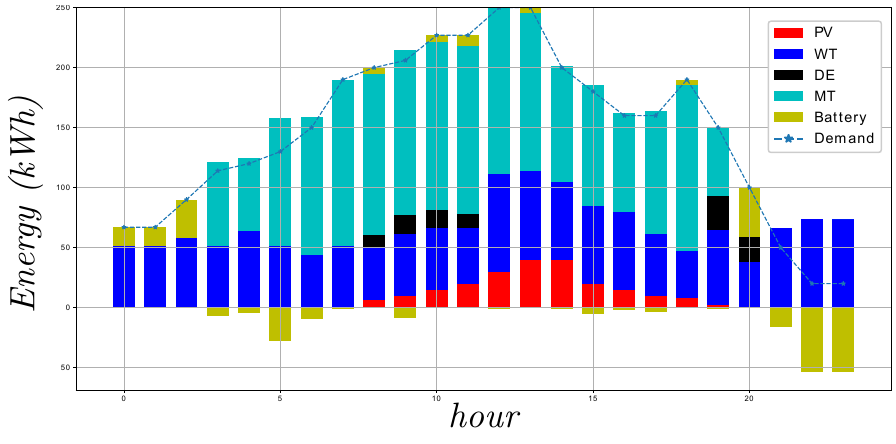
Figure 8. UC and ED solution for Case Study 1.